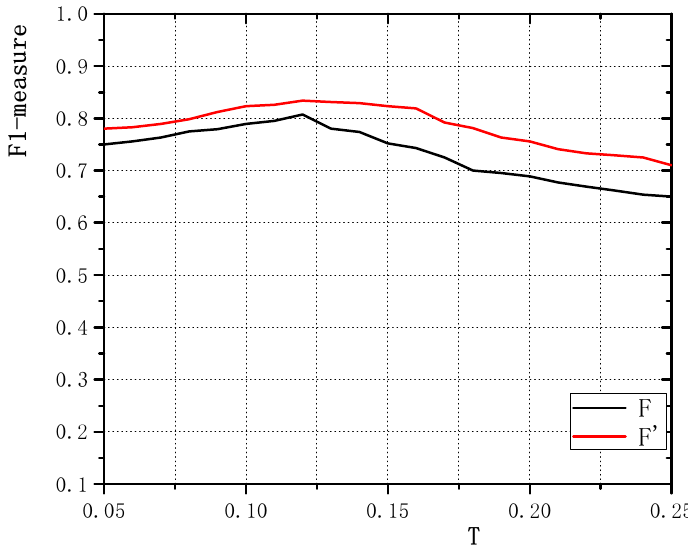
Figure 8. Effects of the parameter T on F1-measure s ( F and F (cid:48) ) for the Type-II RSDDs data